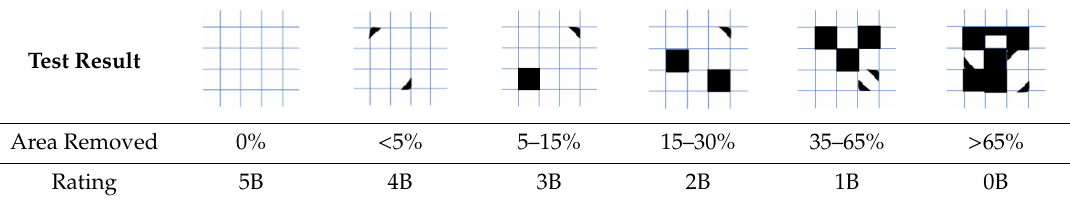
Table 6. Test patterns for the ASTM D3359